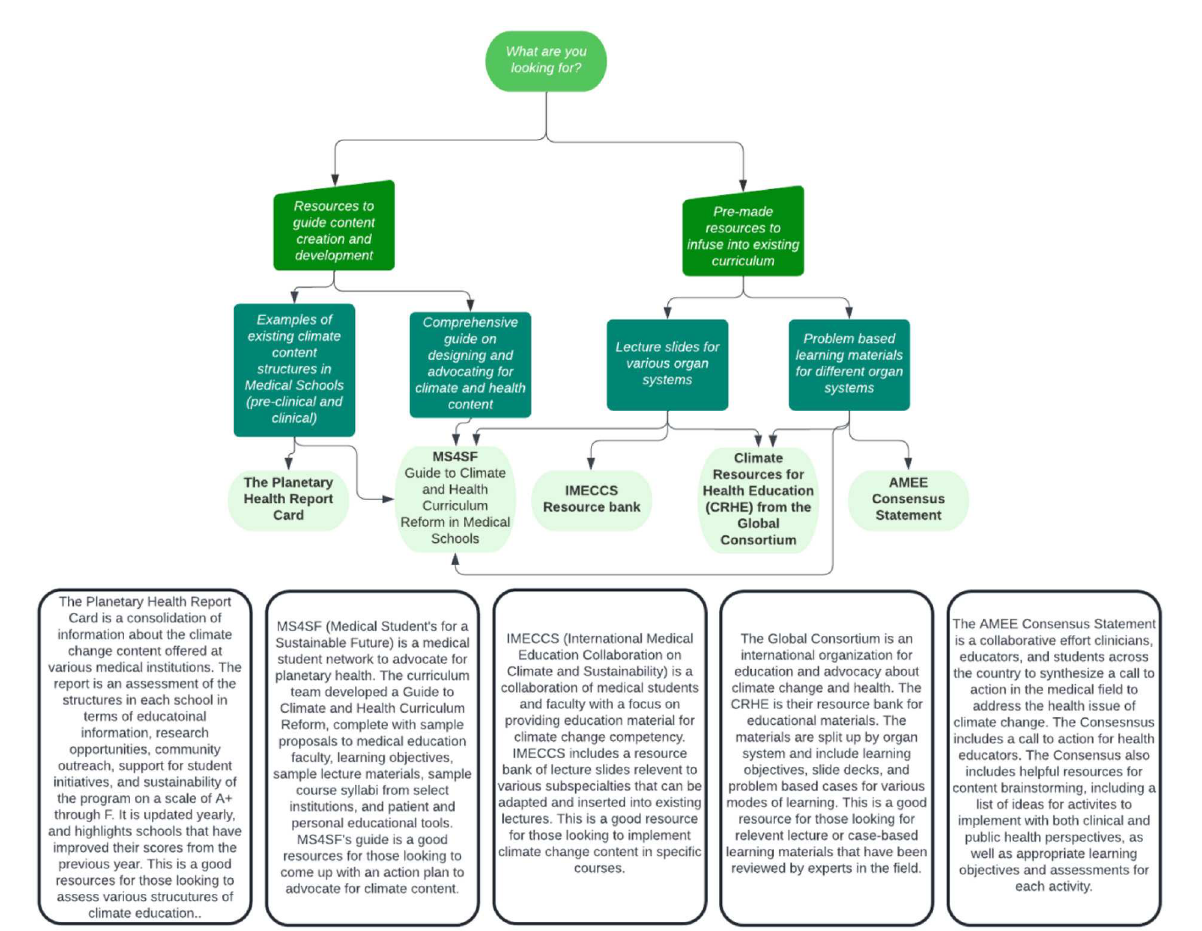
FIGURE2 A guide for the various available resources for climate change content development and implementation [graphic created by Lucy Greenwald with information sourced from https://phreportcard.org/, https://ms4sf.org/, https://www.imeccs.org/, https://climatehealthed.org/, and (39)].